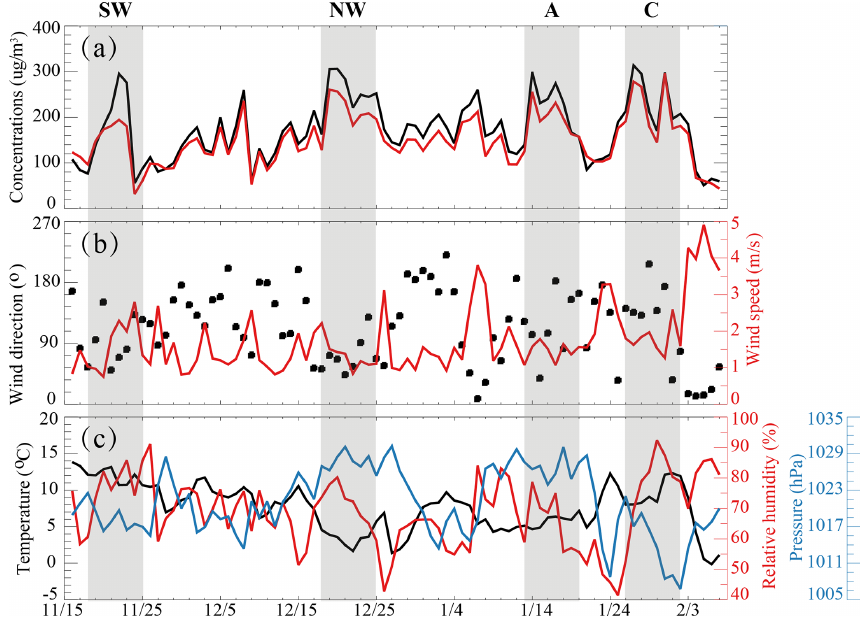
Figure 5. (a) Daily mean values of modeled (red line) and observed (black line) PM 2 . 5 concentration (µg / m 3 ) at Jingzhou and four severe pollution events (grey area) from November 2013 to February 2014. (b) Observed daily mean wind speed (red line) and wind direction (black dots). (c) Observed temperature (black line), relative humidity (red line), and sea level pressure (blue